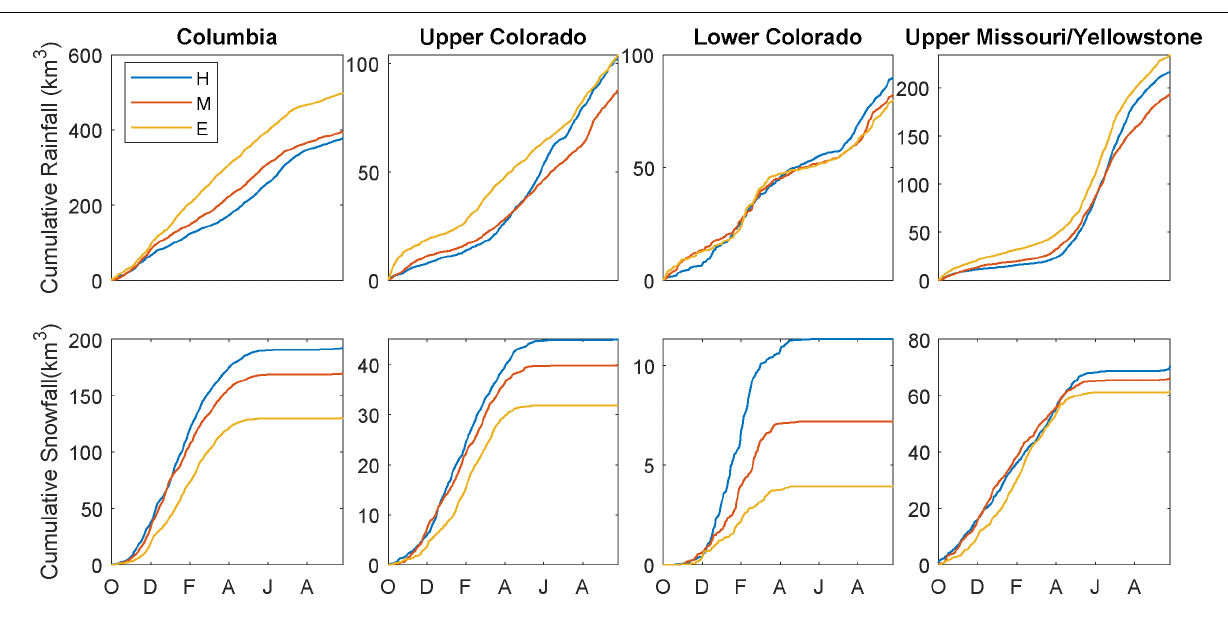
level; Table 1 ). Of the other three basins, all are projected to have less annual streamflow, with the Upper Colorado ( − 31.7%) and Lower Colorado ( − 31.2%) having the largest